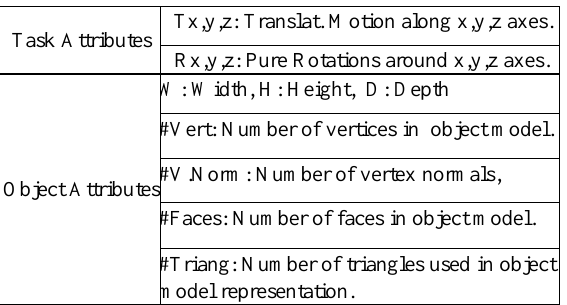
Table 2 Input Vector of ANN.